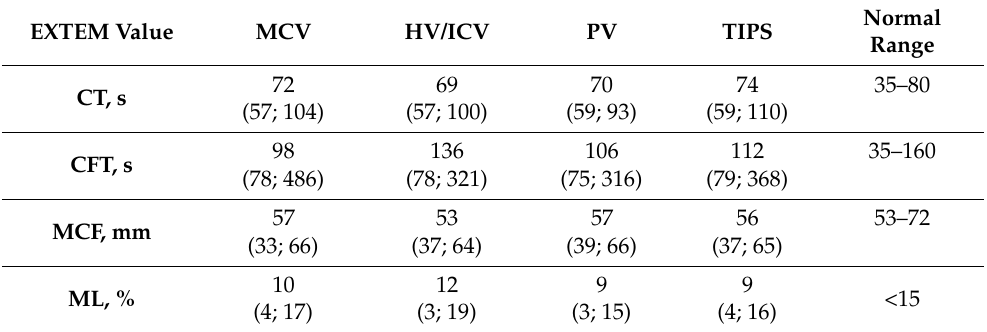
Table 2. Rotational Thromboelastometry (ROTEM ® ) measurements shown as median (min;